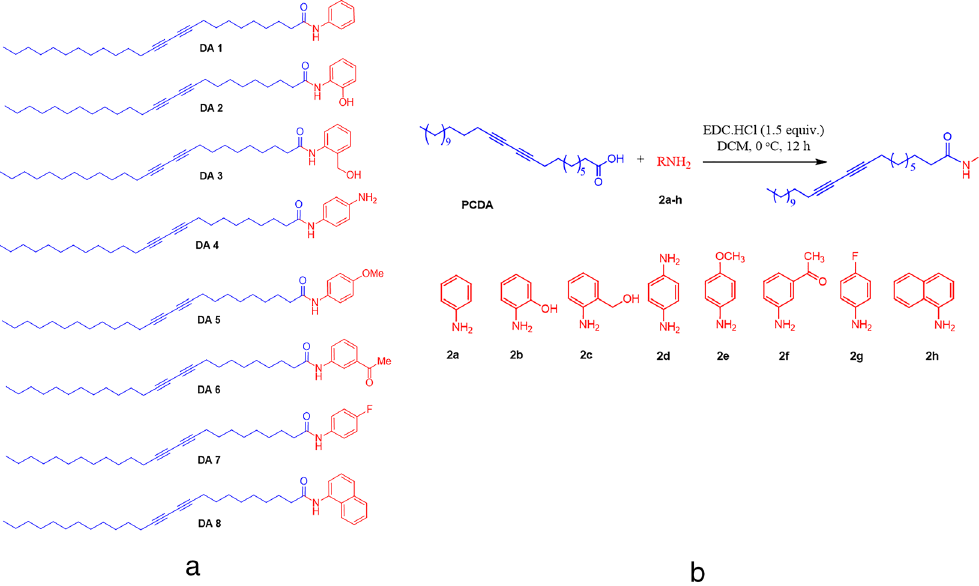
Figure 1. ( a ) Structure of the synthesized diacetylene derivatives DA 1–8. ( b ) Reaction scheme for the synthesis of diacetylene